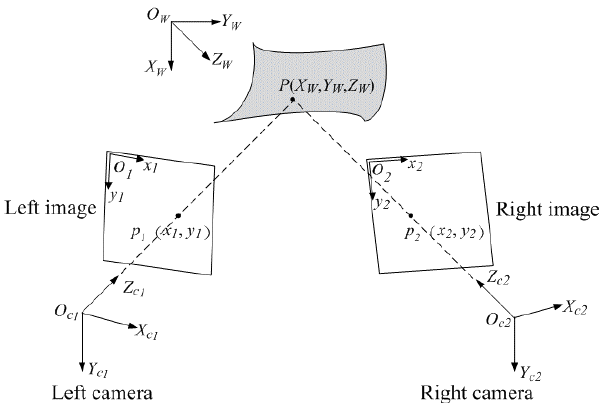
Figure 2. Principle of binocular stereo-vision.